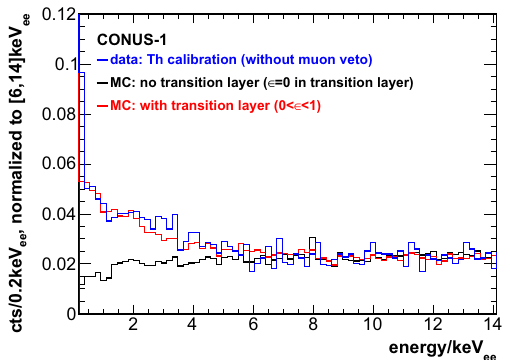
Fig. 4 Comparison of 228 Th calibration data of C1 collected at KBR in the lowE regime to MC simulations. The black spectrum corresponds to the simulation without an implemented transition layer; for the red spectrum, the charge collection efficiency was modeled in the post- processing of the MC